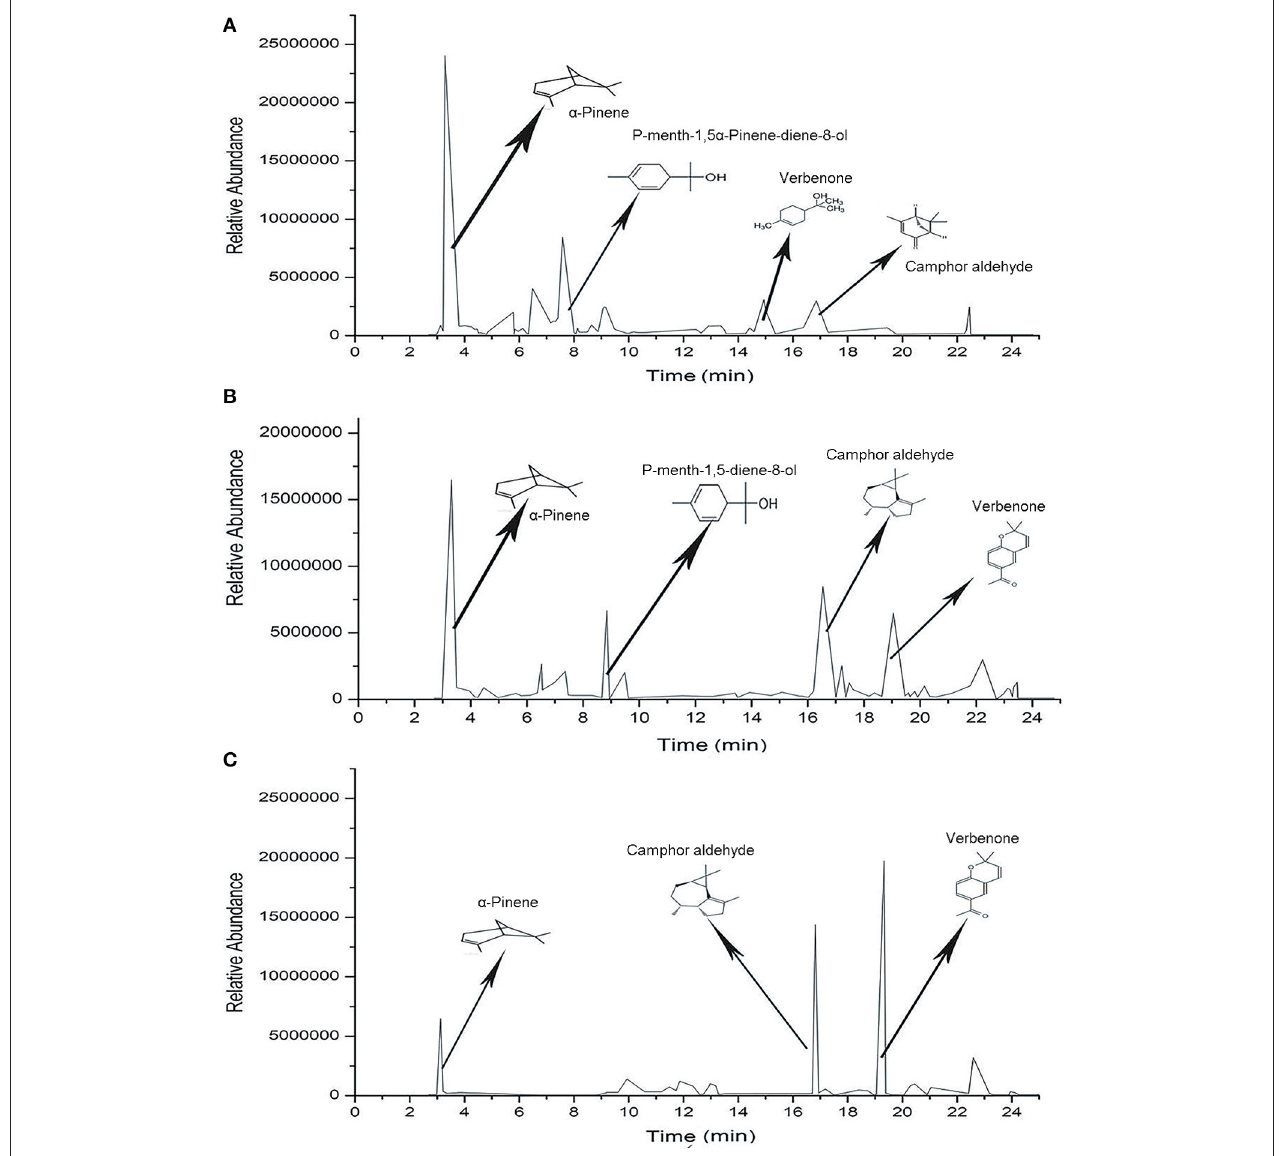
FIGURE 3 | Chromatograms of the chemical compounds of SEOs from different varieties of sunflowers. (A) Chromatogram of chemical compounds of SEOs from LD5009. (B) Chromatogram of chemical compounds of SEOs from SH363. (C) Chromatogram of chemical compounds of SEOs from S606.